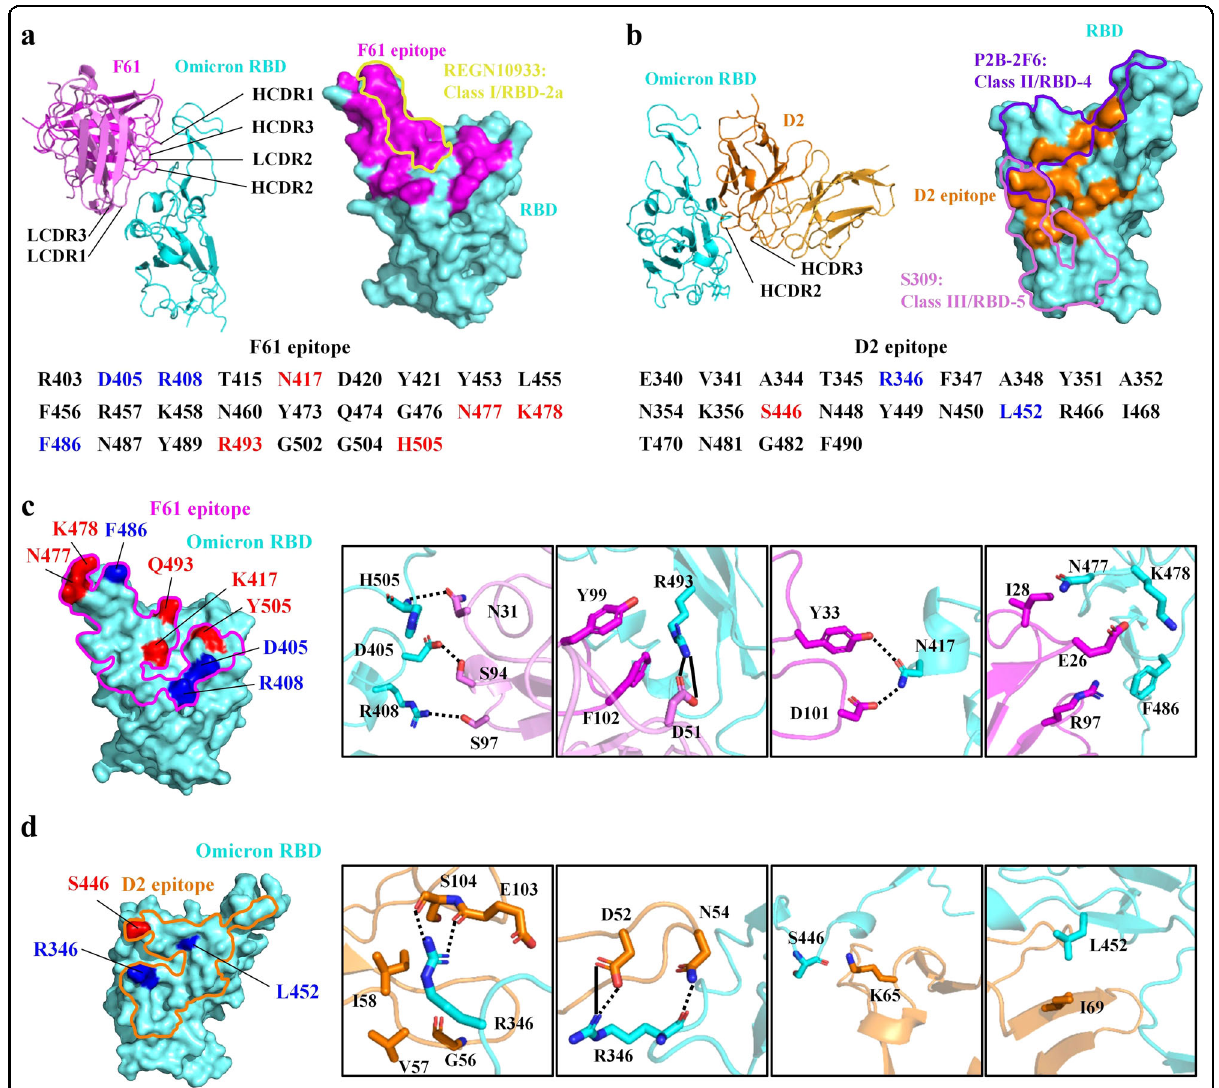
Fig. 4 Structural basis for the potent and broad neutralization. a Overall structure of Omicron-RBD-BA.1 bound with F61 and CDRs involved in binding are labeled. On the RBD, the footprint of F61 is represented by magenta surface and the footprint of REGN10933 (PDB ID: 6XDG) is circled by yellow line. Omicron-RBD-BA.1 residues recognized by F61 are listed and mutated N417, N477, K478, R493 and H505 in BA.1 are colored red. Additional mutations sites in BA.2 (D405 and R408), BA.3 (D405), BA.4 (D405, R408 and F486) and BA.5 (D405, R408 and F486) are colored blue. b Overall structure of Omicron-RBD-BA.1 bound with D2 and CDRs involved in binding are labeled. On the RBD, the footprint of D2 is represented by orange surface and the footprints of P2B-2F6 (PDB ID: 7BWJ) and S309 (PDB ID: 6WPS) are circled by purple and violet lines, respectively. Omicron- RBD-BA.1 residues recognized by D2 are listed and mutated S446 in BA.1 is colored red. Additional mutation site in BA.1.1 (R346) and only L452 mutation site in BA.4 and BA.5 are colored blue. c The detailed interactions between residues mutated in above Omicron sublineages and F61. F61 footprint is circled by a magenta line. Interfacing residues of Omicron-RBD are shown as cyan sticks and F61 are shown as magenta sticks. Hydrogen bonds and salt bridges are represented by dashed lines and solid lines, respectively. d The detailed interactions between residues mutated in above Omicron sublineages and D2. D2 footprint is circled by an orange line. Interfacing residues of Omicron-RBD are shown as cyan sticks and D2 shown as orange sticks. Hydrogen bonds and salt bridges are represented by dashed lines and solid lines,